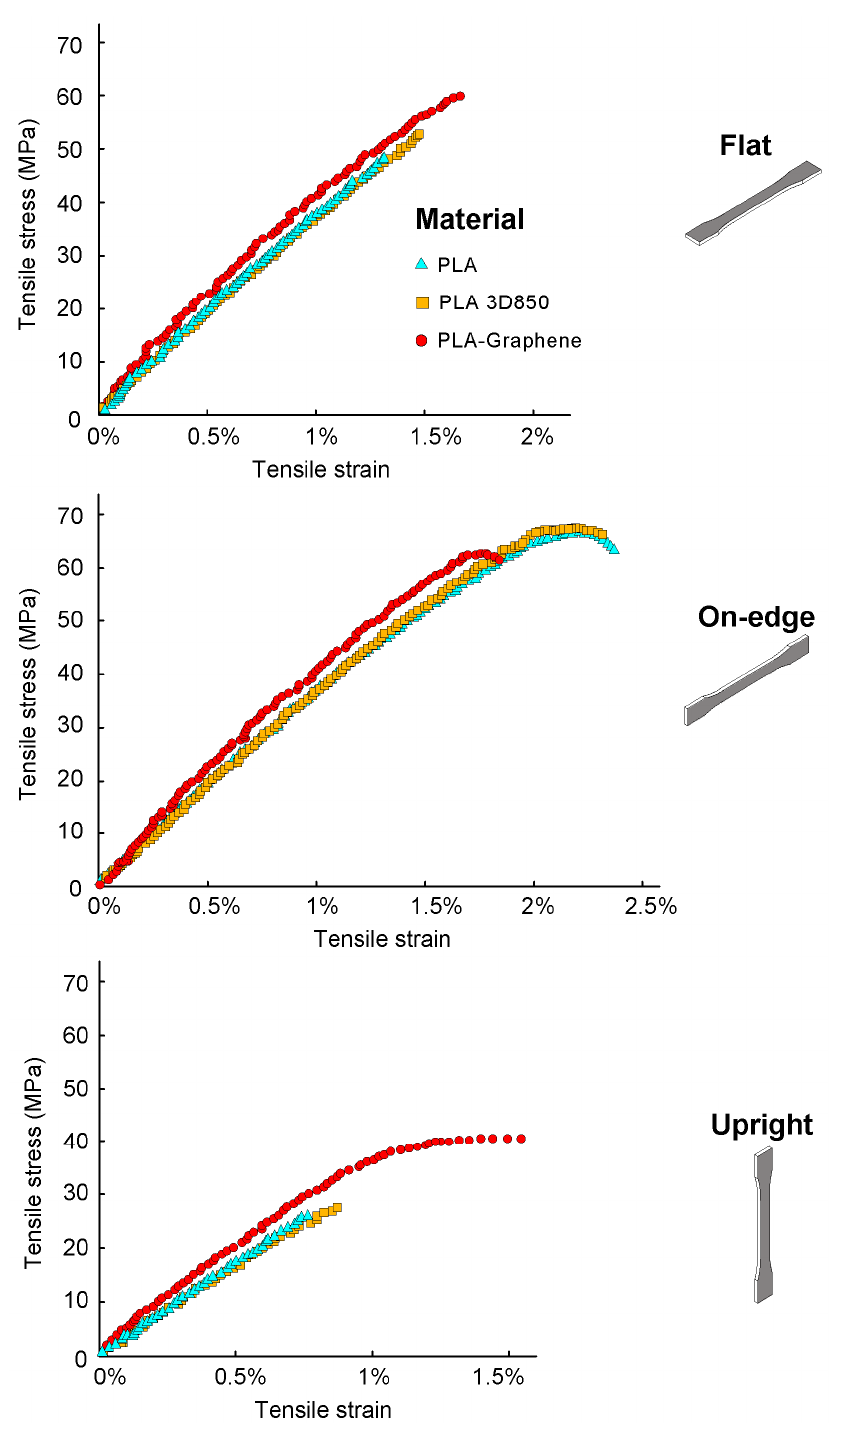
Figure 4. Average tensile stress–strain curves for the 3D printed PLA-based samples as a function of the material and the build orientation.